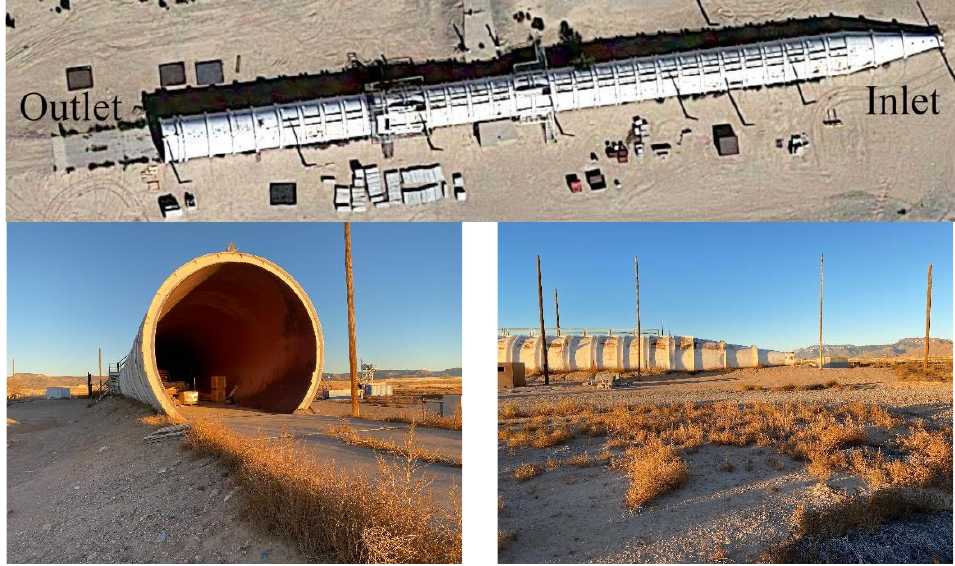
Figure 1. Satellite view ( top ) and photos ( bottom ) of the outlet ( left ) and inlet ( right ) of the Shock Tube. Shock